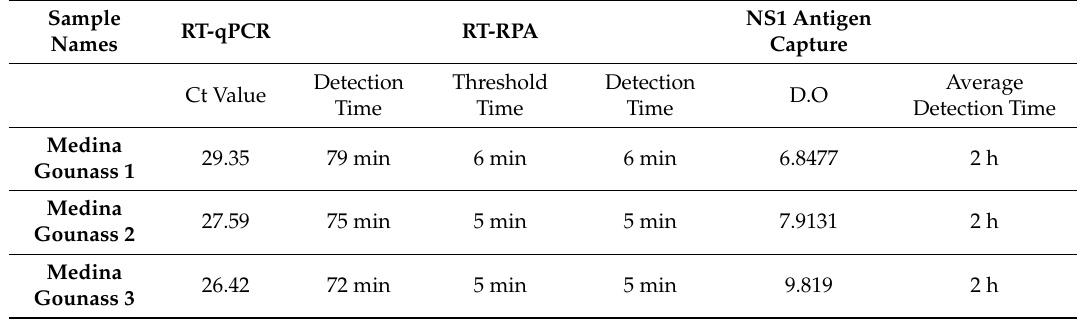
Table 1. Comparison of time detection between non-structural protein 1 (NS1), real-time recombinase polymerase amplification (RT-RPA), and RT-PCR.